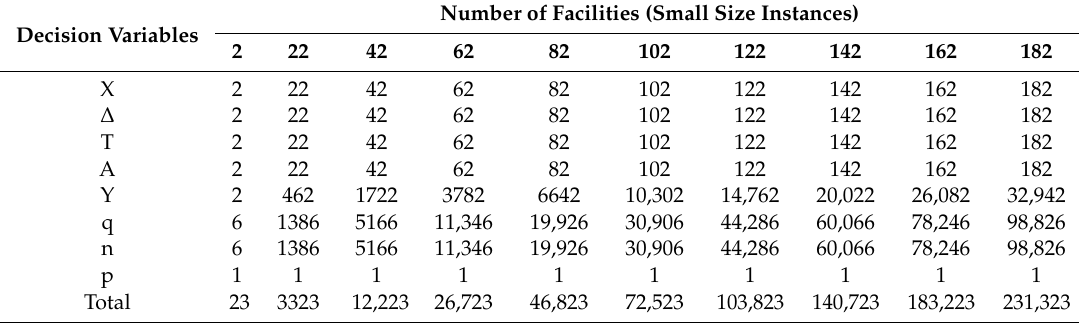
Table 5. CLITraP-HTF dimension of decision variables for scenarios with di ff erent number of facilities. Decision